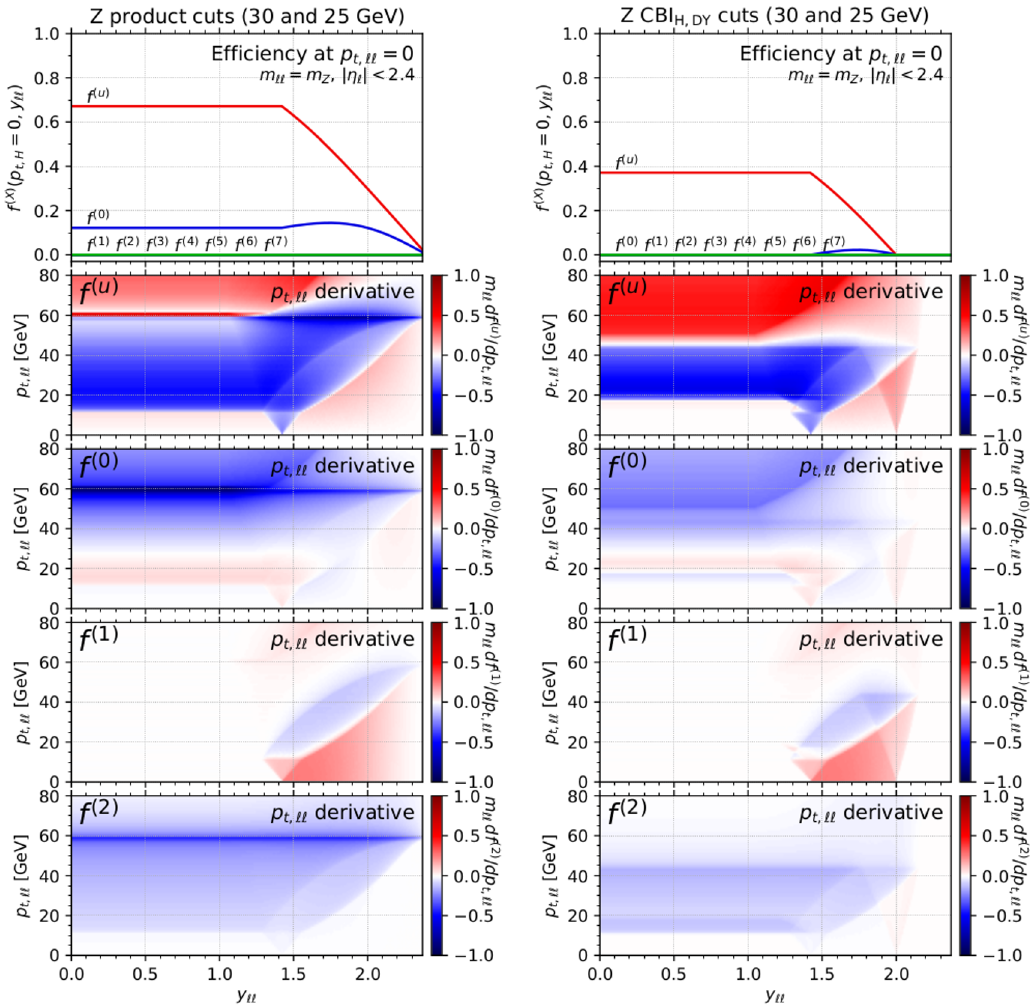
Figure 16 . Top panels: p t,‘‘ = 0 harmonic acceptances for Z → ‘ + ‘ − , as defined in eq. (6.4), for each of the spherical harmonic functions in eq. (6.2). Lower panels: the p t,‘‘ = 0 derivatives of the acceptances for the f ( x ) that are non-zero. The left-hand column shows results for product cuts, the right-hand column for the CBI H cuts supplemented with the condition in eq. (6.7) (which,